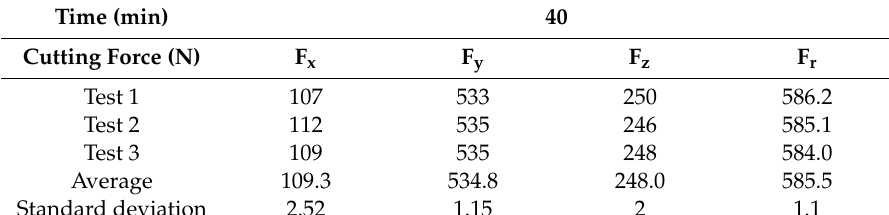
Table 7. The cutting force at the 40 min of the experiment for Tool B.